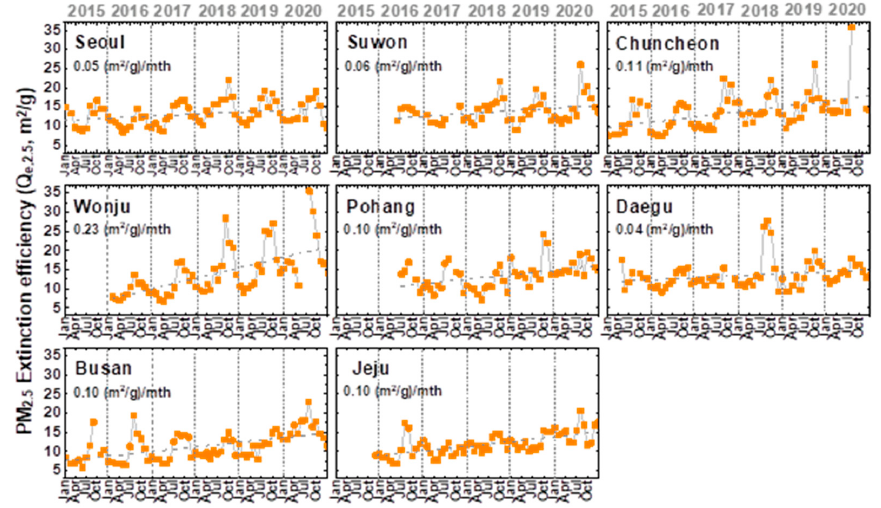
Figure 6. Q e,2.5 monthly average and trend from 2015 to 2020. Table 7. MK Test and Sen’s slope for monthly trends of PM 2.5 , Q e,2.5 during 2015–2020 (clear trend with 95% CL for |z| > 1.96 and 99% CL for |z| > 2.57). Visibility PM 2.5